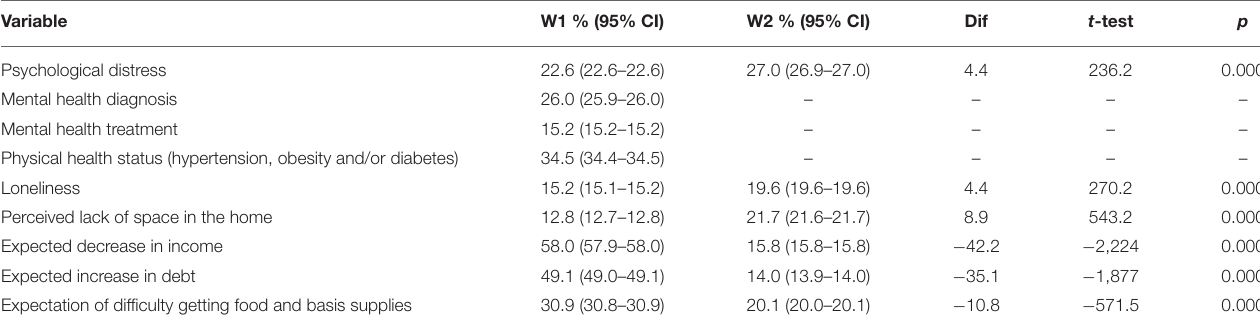
TABLE 2 | Psychosocial and health variables by study wave ( n = 10,599,608). Variable Psychological distress